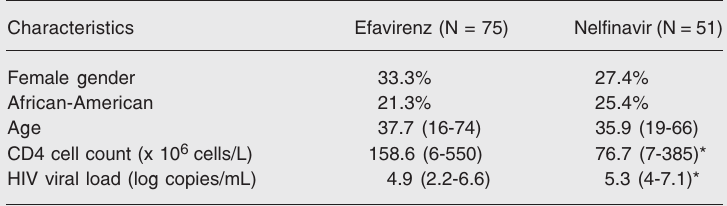
Table 1. Basal characteristics of the antiretroviral-naive patients at the beginning of therapy. Characteristics